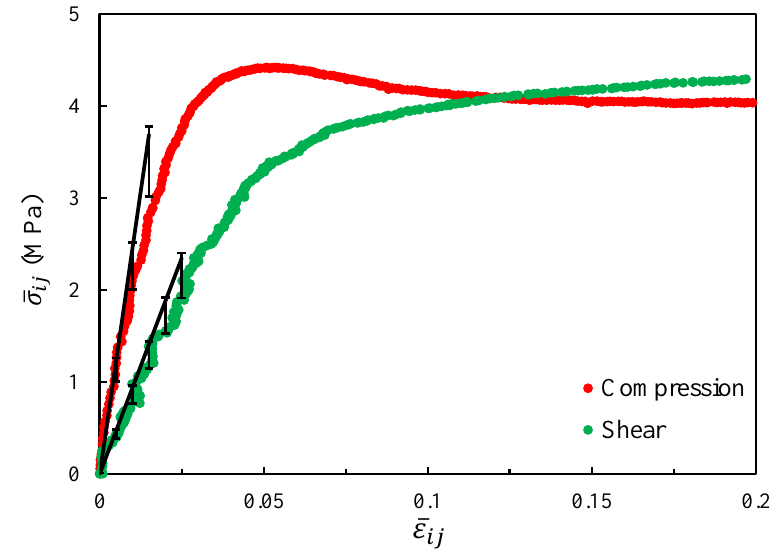
Figure 17. Stress–strain curves of the macroscopic compression and shear tests (the effective elastic moduli obtained by numerical simulations are shown with the black